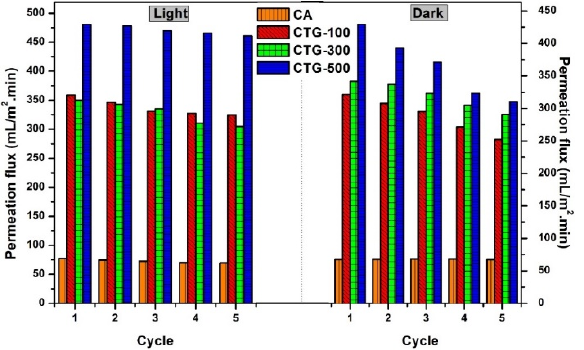
Figure 7. Recyclability of the as-prepared membrane and pure water permeability in the presence and absence of visible light.